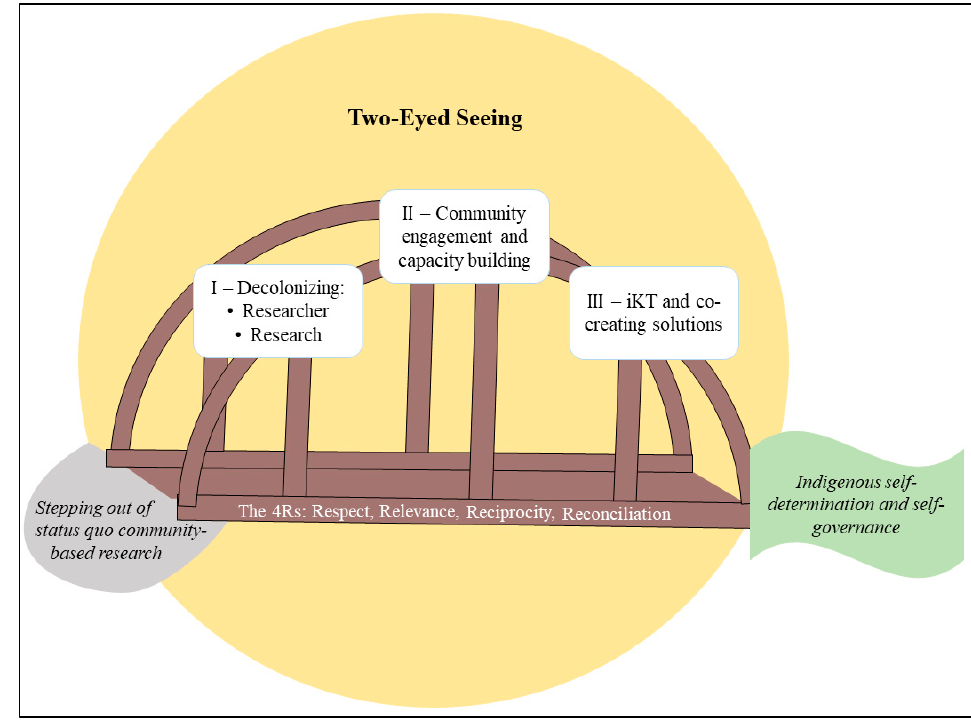
Figure 1. The Bridge Framework for decolonizing digital citizen science.